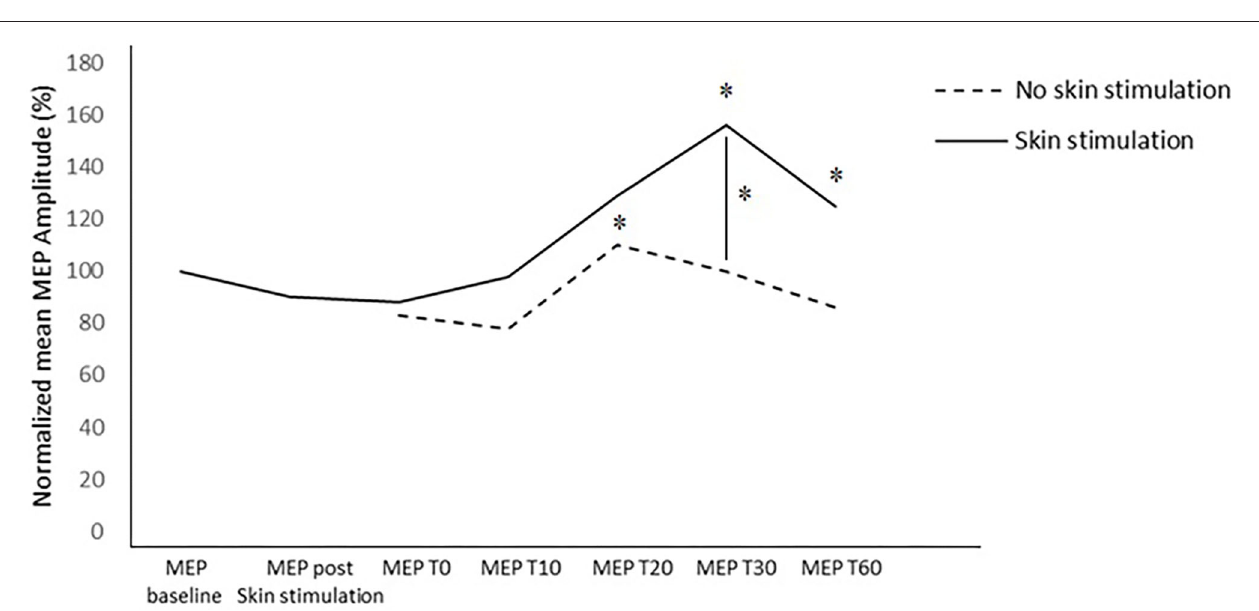
FIGURE 4 | Normalized MEP amplitude in the two trials at the different time points. * = p < 0.05.